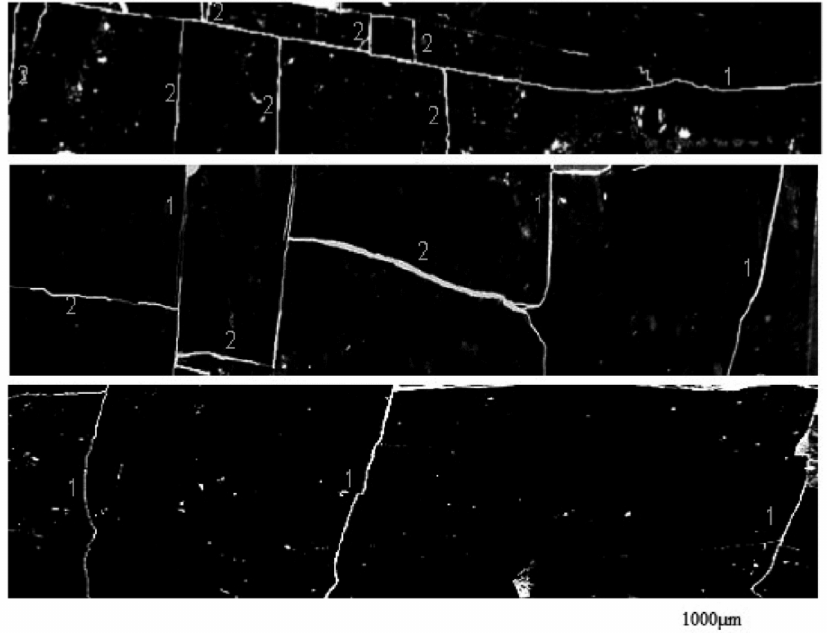
Figure 7. Structure of the fractured coking coals, S.D. Tihov mine, Leninsky area, Kuzbass; 1 indicates face cleats, 2 indicates butt